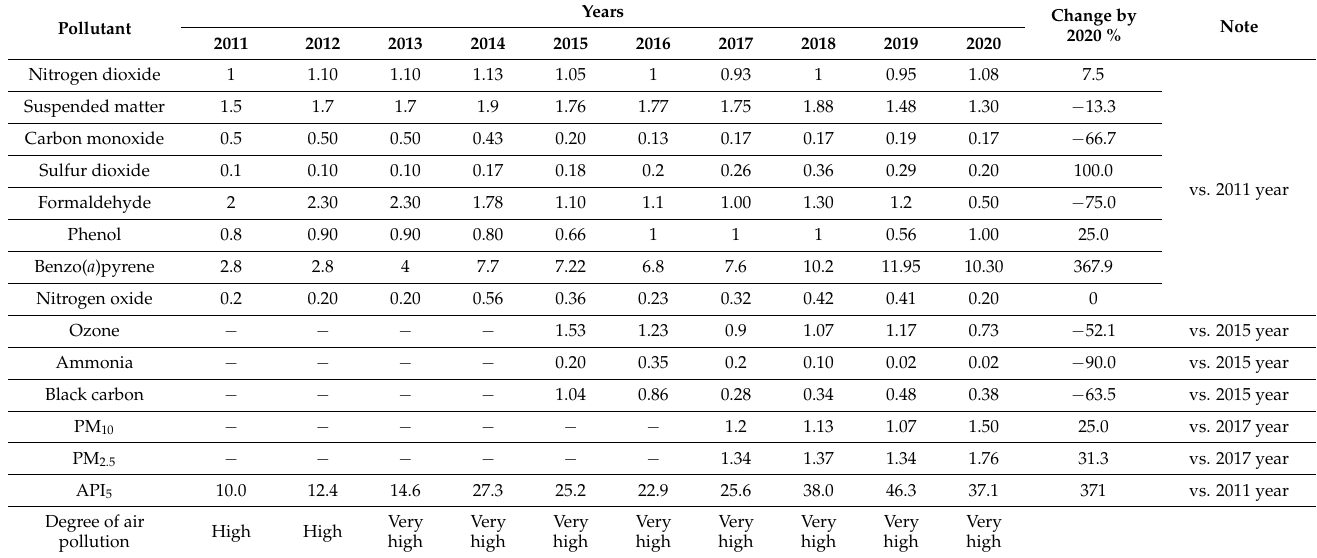
Table 2. Dynamics of the average annual concentrations of pollutants, API, and degree of air pollution in Ulan-Ude in 2011–2020 (according to the Buryat CHEM), in shares of MAC.